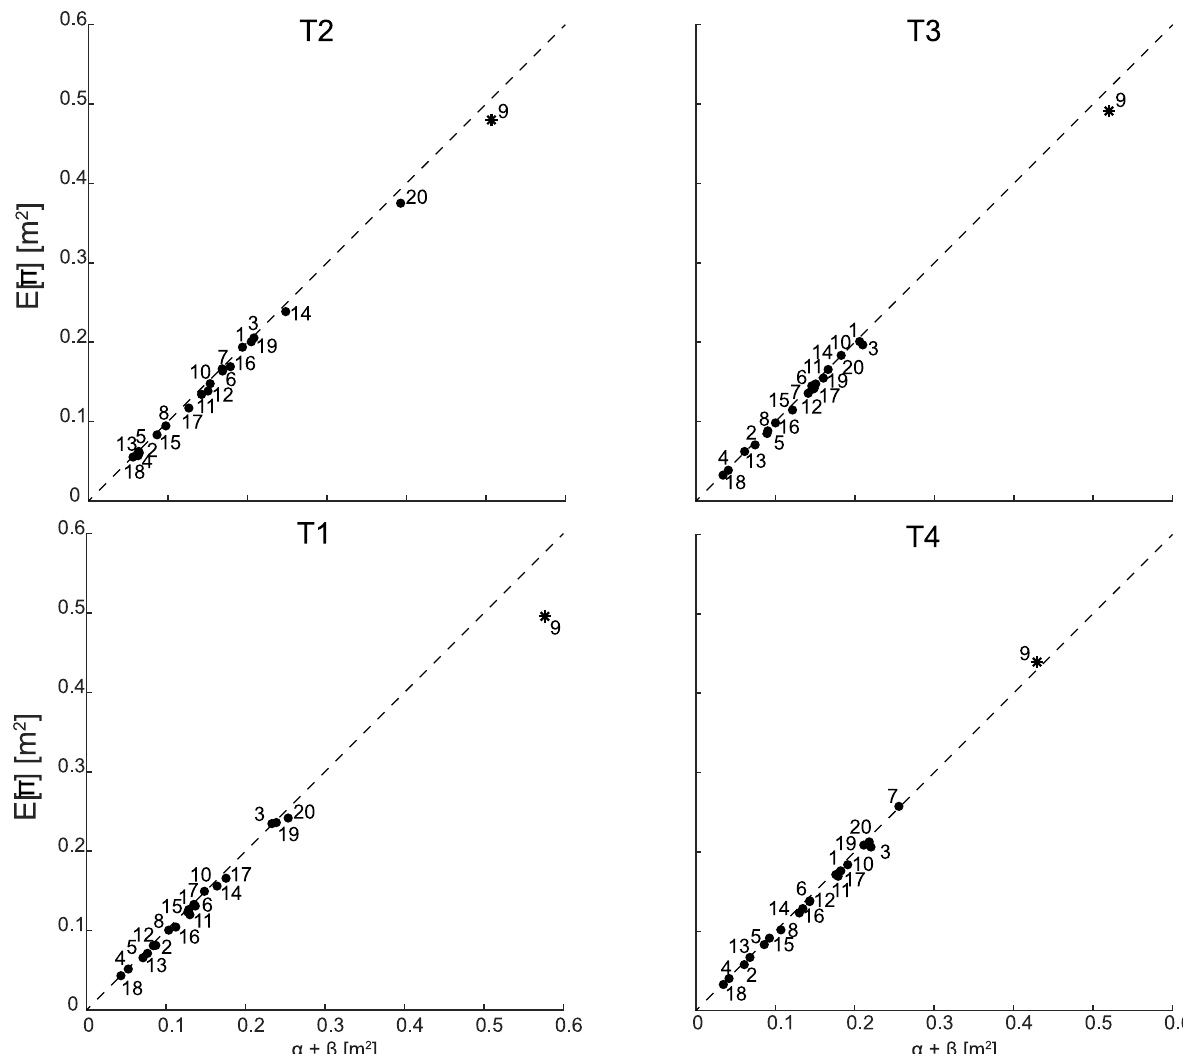
Fig 6. Validity of the quadratic approximation. Mean score vs. quadratic approximation (8) across targets (T1-T4, different panels ) and participants ( P 1- P 20)as in Fig 1. Note that P 9 is the only participant deviating substantially from the identity line ( dashed line ).